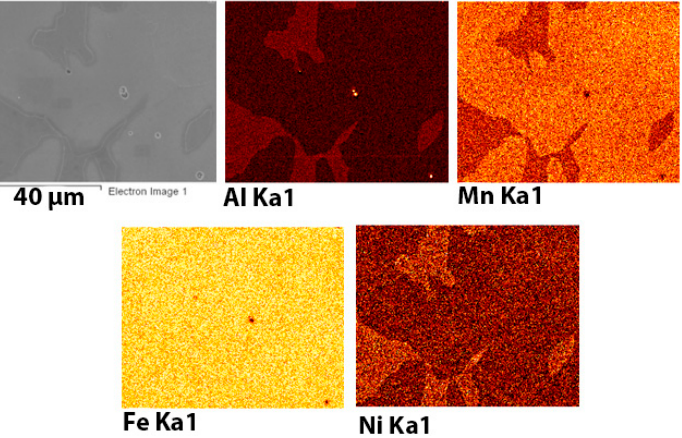
Figure 5. EDS elemental mapping of Al, Mn, Fe and Ni in the matrix of the investigated steel.